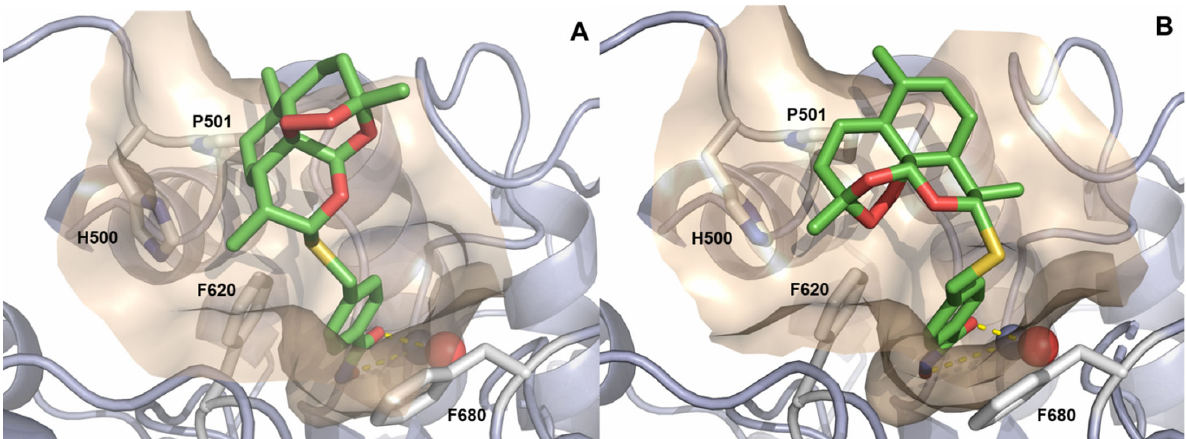
Figure 3. Docking pose of ( α ) ‐ 7c ( A ) and ( β ) ‐ 7c ( B ) in the catalytic domain 2 of HDAC6 (PDB: 5EDU [29]). Ligands are colored green and are depicted as sticks. The catalytic Zn 2+ ‐ ion is shown as a gray sphere, and water is shown as a red sphere. The protein backbone is shown as light blue cartoon including the wheat ‐ colored protein surface surrounding the ligand. The binding interactions of the hydroxamic acids are depicted as yellow, dashed lines.